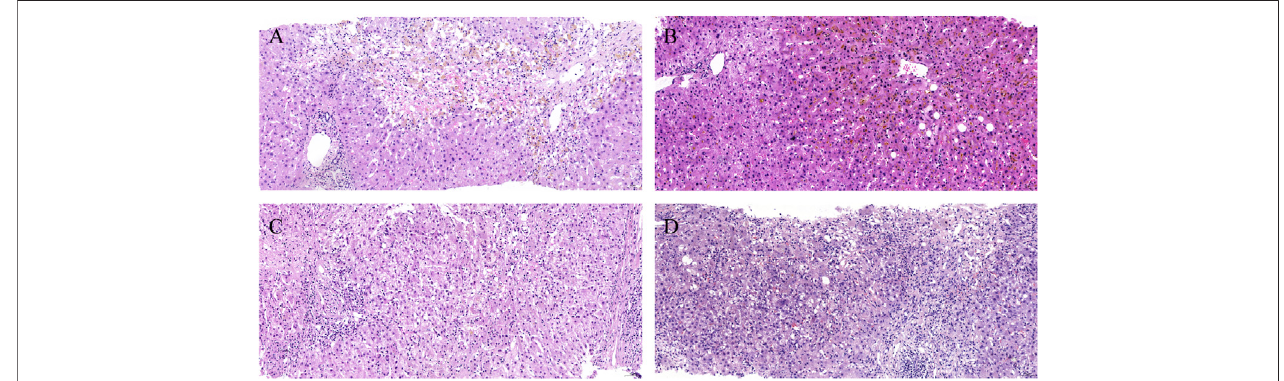
FIGURE 5 | Histological injury patterns. (A) Histological acute hepatitis pattern (lobular necroin fl ammation with cholestasis) mainly correlated with the ALT-mono- peak pattern. (B) Histological acute cholestasis pattern (hepatocellular and canalicular cholestasis without obvious necroin fl ammation) mainly correlated with the TB- mono-peak pattern. (C) Histological cholestatic hepatitis pattern (mild to moderate lobular necroin fl ammation with mild cholestasis) mainly correlated with the ALT and TB double overlap peak pattern. (D) Histological cholestatic hepatitis pattern (moderate to severe lobular necroin fl ammation with moderate cholestasis) mainly correlated with ALT and TB double separate peak patterns. Abbreviations: ALT, alanine aminotransferase; TB, total